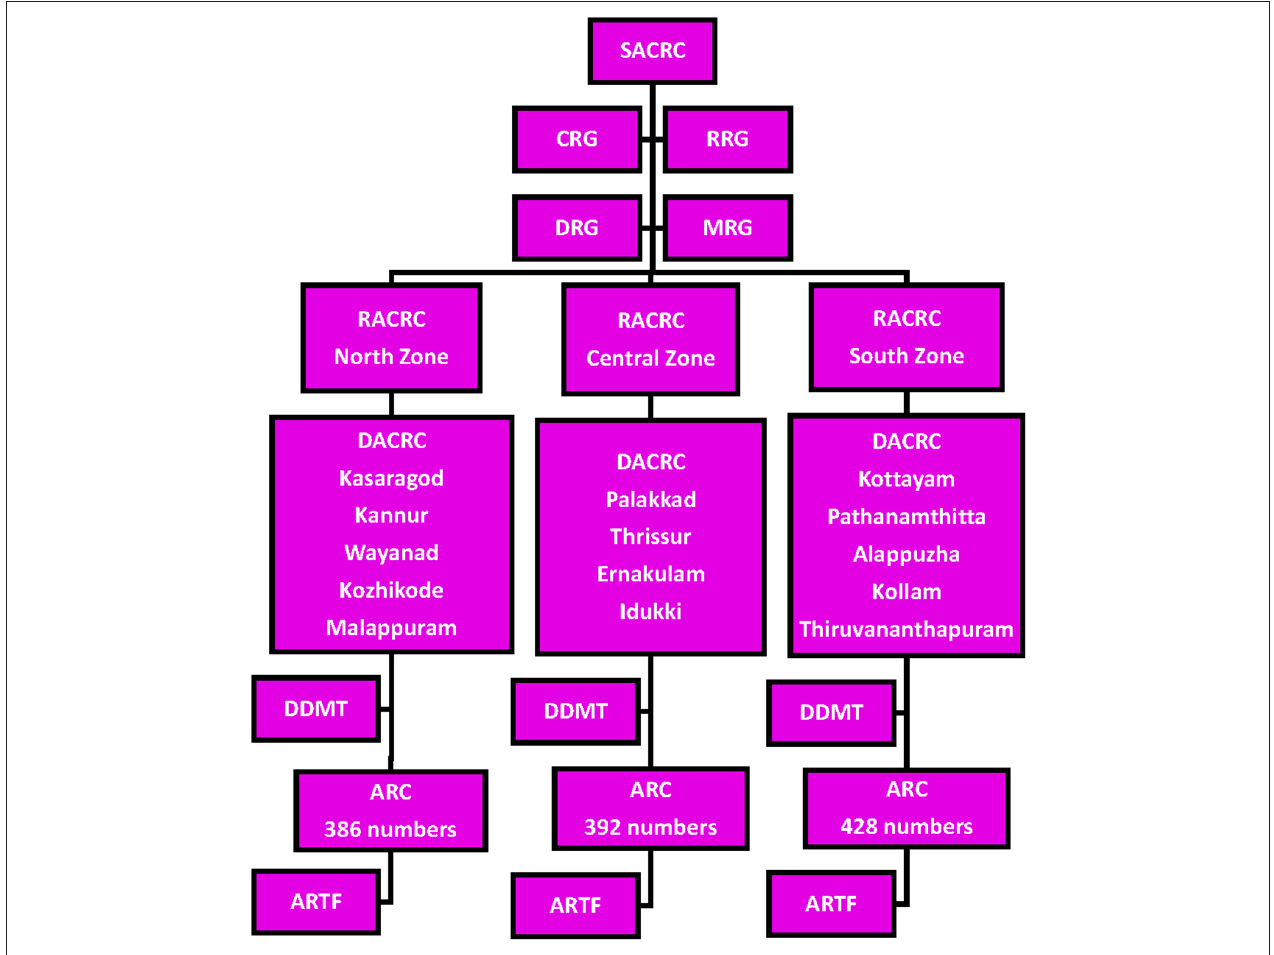
FIGURE 1 | The organizational algorithm of Ayurvedic Response in Kerala. SACRC, State Ayurveda COVID-19 Response Cell; RACRC, Regional Ayurveda COVID-19 Response Cell (based on three zones of the state); DACRC, District Ayurveda COVID-19 Response Cell (function at the 14 districts of Kerala); ARC, Ayur Raksha Clinics (work at village level); ARTF, Ayur Raksha Task Force (ground level supporting body of ARC); CRG, Clinical Resource Group; RRG, Research Resource Group; DRG, Drug Resource Group; MRG, Multimedia Resource Group; DDMT, District Data Management